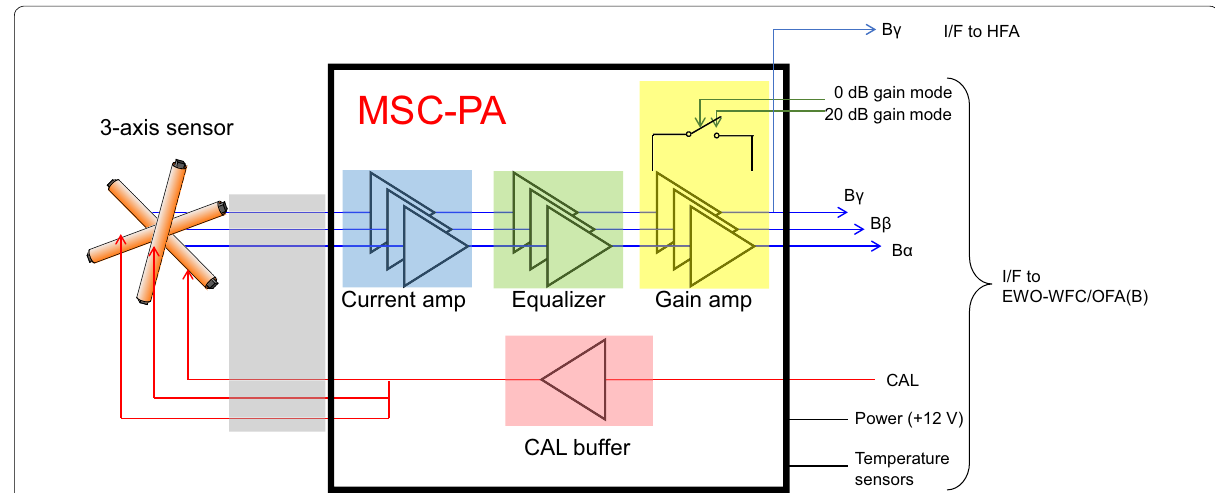
Fig. 7 Simplified block diagram of the MSC sensors and preamplifiers. Three components of the magnetic field below 20 kHz and one component of the magnetic field along the satellite spin axis from 10 to 100 kHz are fed to the WFC/OFA(B) and the HFA,